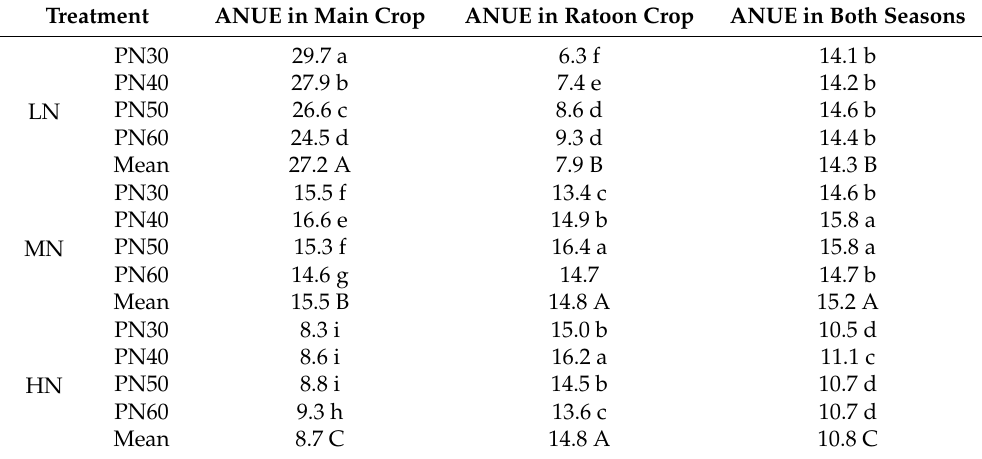
Table 6. Effects of N regime in the main crop on the nitrogen use efficiency in the main and ratoon crop. Treatment